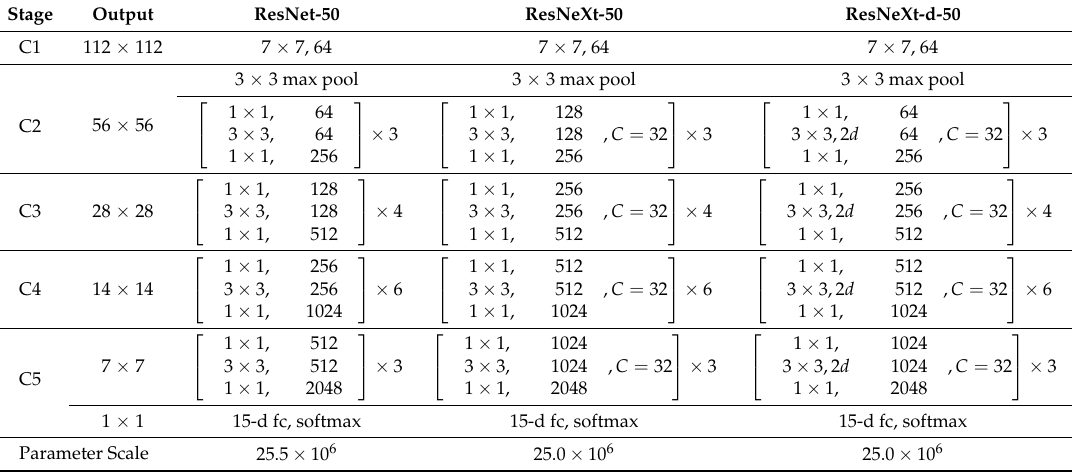
Table 2. Structure of 50 layers of the three backbone